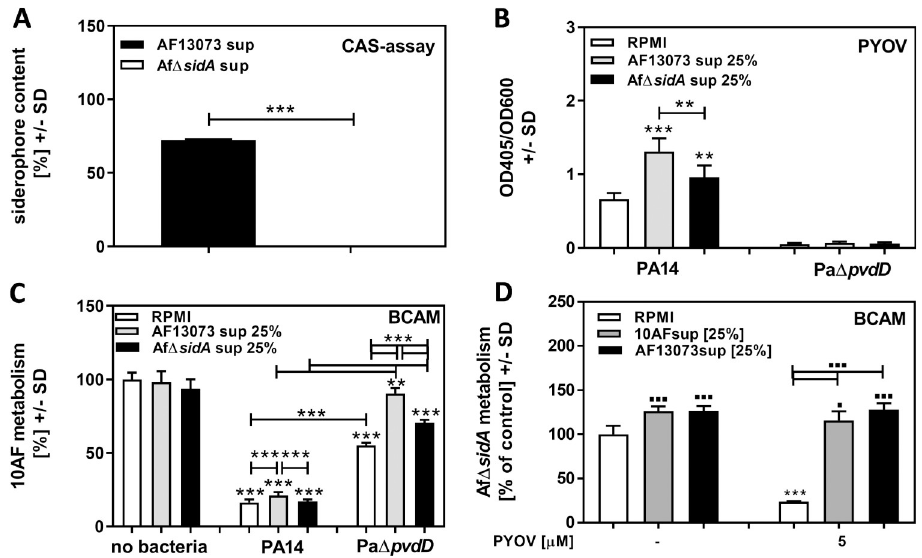
Fig 3. A . fumigatus siderophores protect A . fumigatus biofilm from P . aeruginosa anti-fungal activity. A: Planktonic supernatants produced by an A . fumigatus mutant lacking hydroxamate siderophore production (Af Δ sidA ) or its parental strain (AF13073) were subjected to siderophore production measurement by CAS assay. B: RPMI, or 25% Af Δ sidA or AF13073 supernatant in RPMI, were inoculated with PA14 wildtype or the PA14 mutant Pa Δ pvdD [5x10 7 cells/ml], and incubated at 37˚C for 24h. Pyoverdine production was measured. C: Supernatants obtained in B (middle and right sets of 3 bars), as well as 25% Af Δ sidA or AF13073 supernatants in RPMI (left 3 bars) were tested